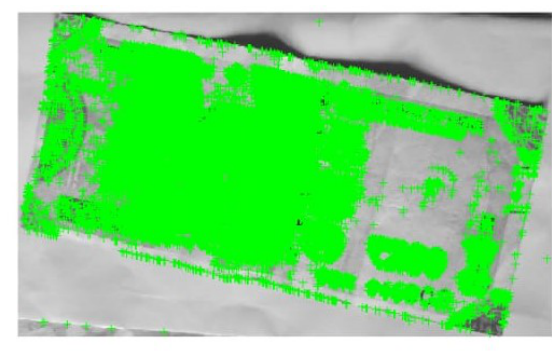
Figure 4. ORB in good lighting